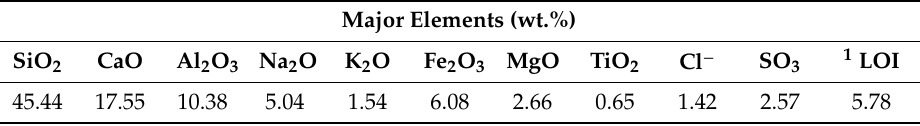
Table 1. Elemental oxide composition of WBA powder.